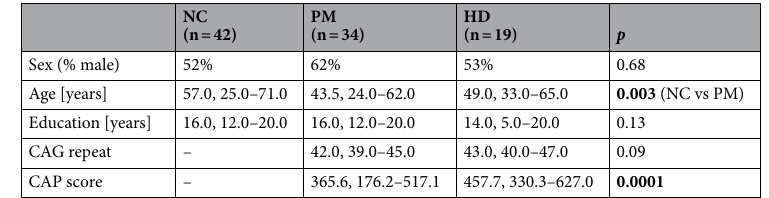
Table 2. Demographic and disease data for subjects used in this study (median, range). Statistical tests used: Sex, Chi square test; Age, Education: Kruskal–Wallis test; CAG repeat: Mann–Whitney U test; CAP score: t-test. CAP, CAG-Age Product score; HD, Huntington’s Disease; NC, normal control; PM, pre-manifest. Significant values are in bold.